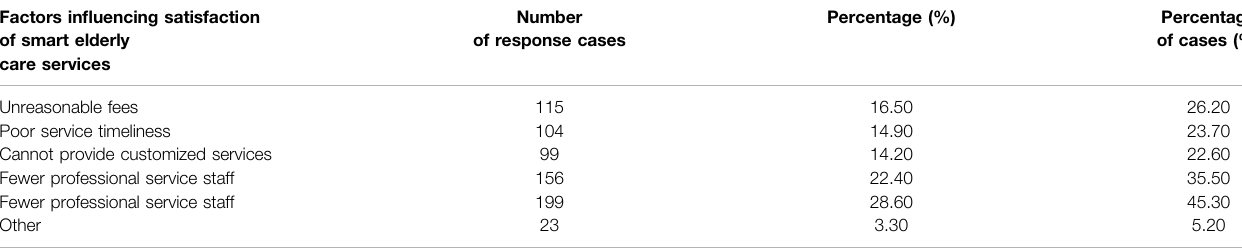
TABLE 4 | Factors affecting satisfaction with smart elderly care services (unit: person).